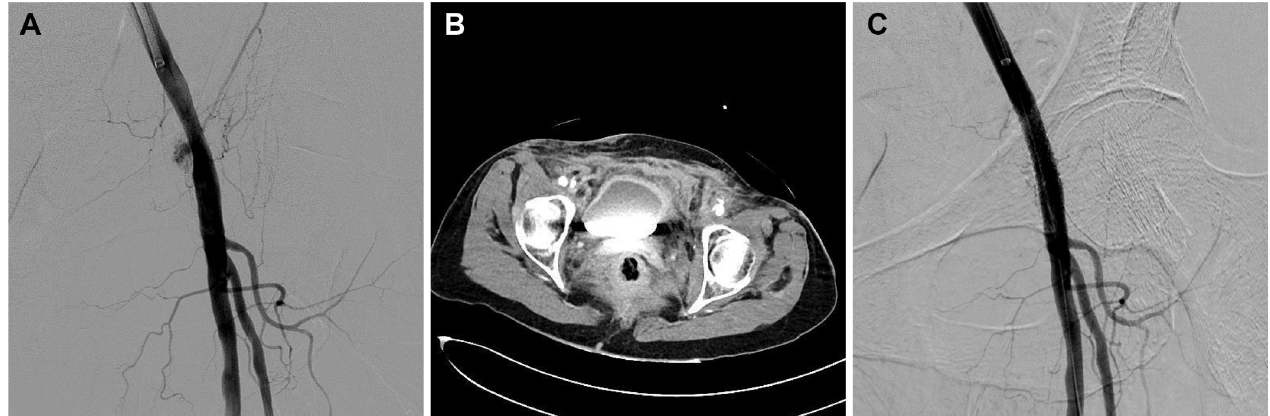
Fig 1. A 66-year-old female experienced a high retrograde puncture above the inguinal ligament, 2.5 cm cranial to the femoral head. Despite manual compression, a rapidly increasing groin haematoma developed. (a) Angiography demonstrated active extravasation from the iliac external artery, immediately above the level of the inguinal ligament. (b) Contrast-enhanced computed tomography scans demonstrated active extravasation from the external iliac artery and an accompanying haematoma. (c) Successful sealing of the perforation was achieved by deployment of an 8 x 26 mm covered stent (LIFESTREAM; C. R. Bard, USA) via a contralateral crossover